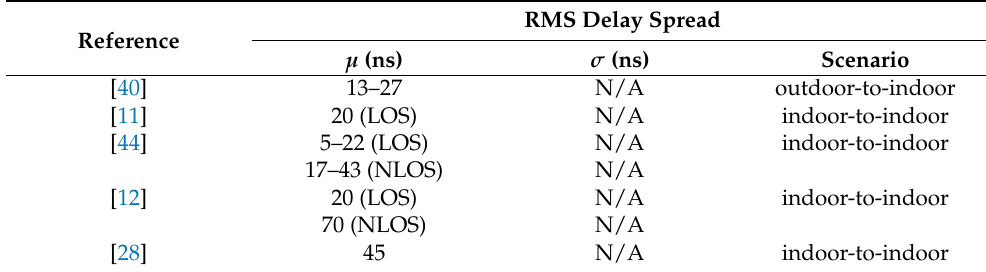
Table 5. RMS Delay spread at 3.5 GHz band from the